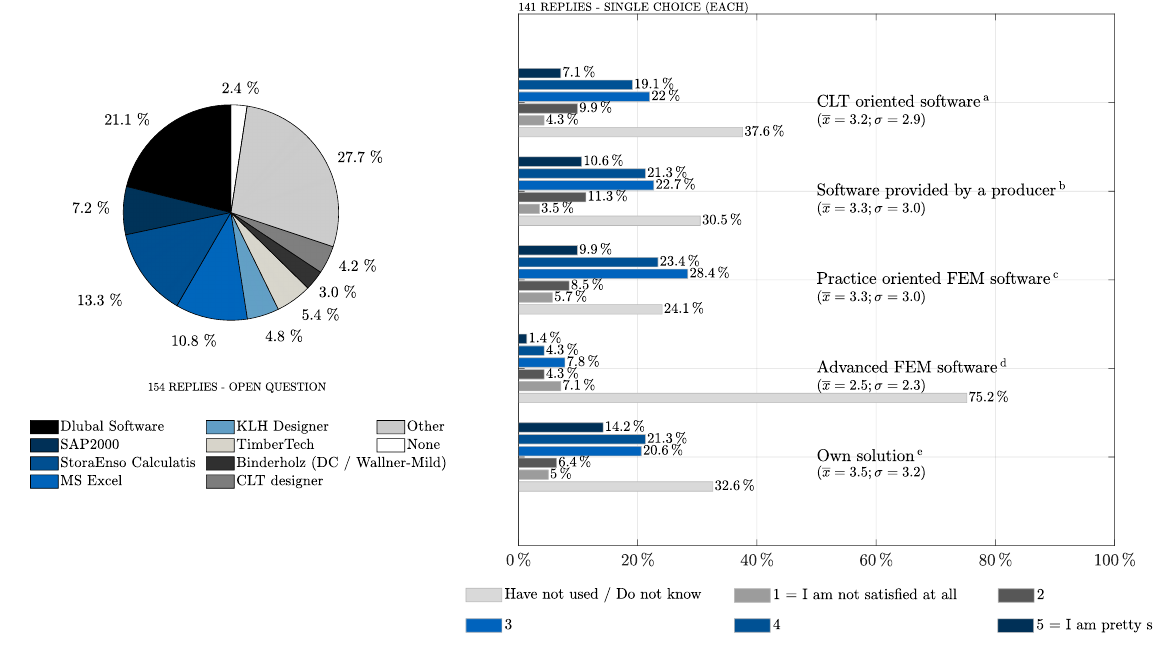
Figure 10. Software used for cross laminated timber (CLT) design ( left ), and satisfaction with available software solutions ( right ). Legend: a CLTdesigner, TimberTech, etc.; b Binderholz (DC/Wallner-Mild), KLH Designer, StoraEnso Calculatis, etc.; c Dlubal , SAP 2000, SOFiSTiK, etc; d Abaqus, Ansys, etc.;